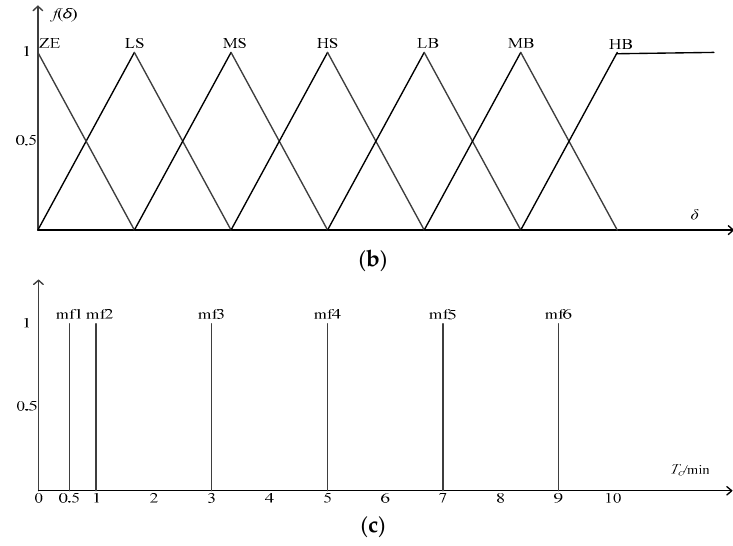
Figure 3. Membership functions: ( a ) The membership function of P c ; ( b ) The membership function of δ ; ( c ) The membership function of T c . Table 1. Rules of fuzzy-logic control.